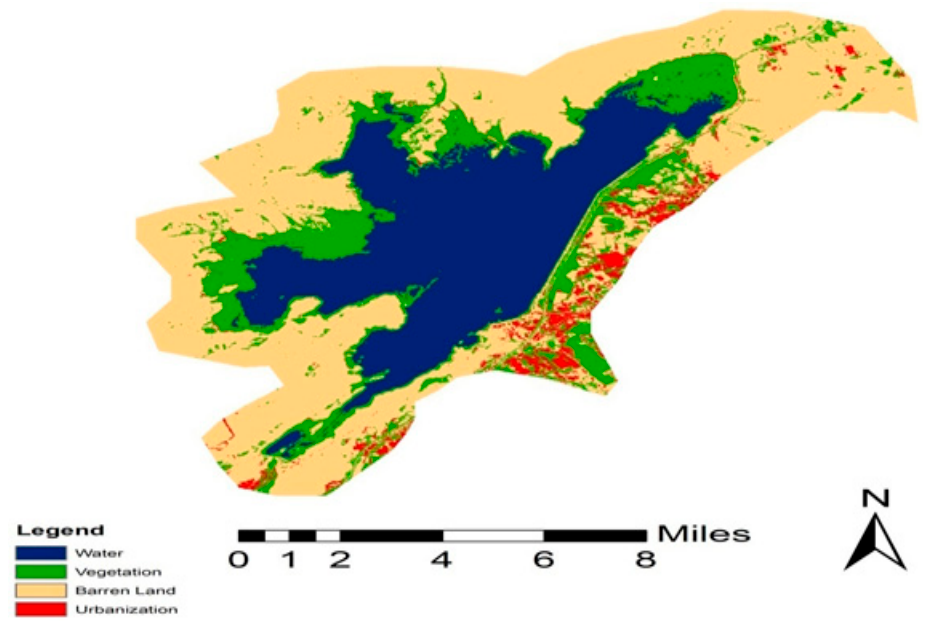
Figure 4. Land cover map of Keenjhar Lake.